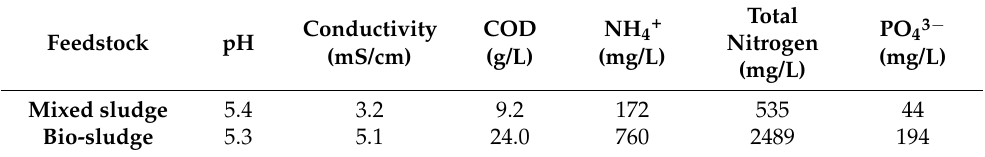
Table 4. Characteristics of the product slurry obtained with the hydrothermal treatment at 190 ◦ C with the autoclave. Reported values for COD, NH 4+ , total nitrogen and PO 43 − correspond to the dissolved